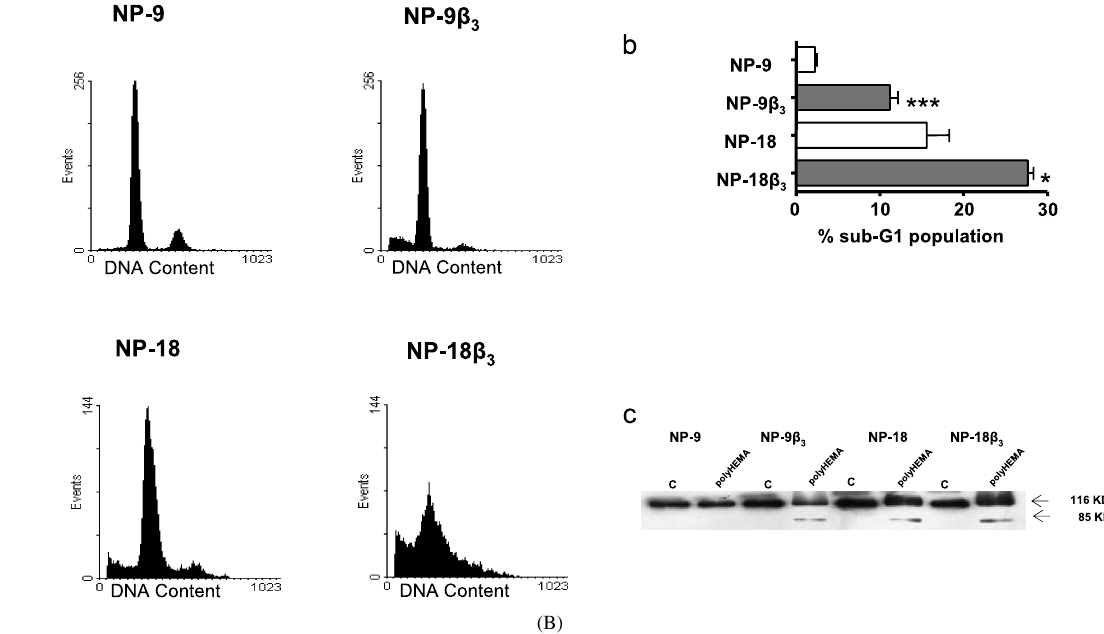
Fig. 5. (B) (a) Cell cycle profiles under non-attachment conditions. Cell cycle distribution was assessed by flow cytometry analysis of propid- ium iodide-stained cells on days 4 (NP-18 and NP-18 β 3 ) and 7 (NP-9 and NP-9 β 3 ) after seeding on poly-HEMA coats. (b) Quantification of the sub-G 1 peak was performed using WinMDI/Multicycle software. (c) Apoptosis under anchorage-independent conditions. Cleavage of poly(ADP-ribose)-polymerase (PARP) was assessed by Western blot detection of the 85 KDa cleaved form of PARP. C – standard conditions; polyHEMA – poly-HEMA